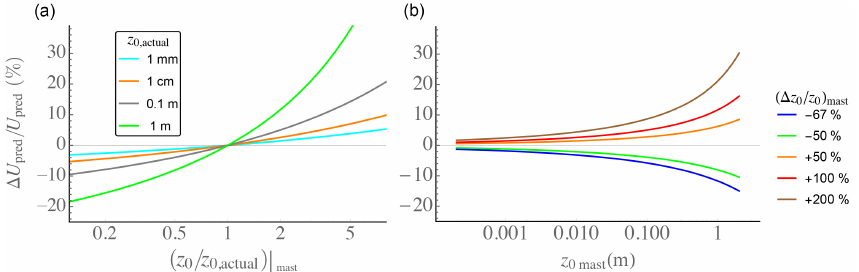
Figure 3. Error in predicted wind speed due to error in background roughness at measurement site via Eq. (8), for observation height z obs = 60m and prediction (hub) height of z pred = 100m. (a) Error vs. ratio ( = a ) of estimated to actual background z 0 . (b) Error vs.